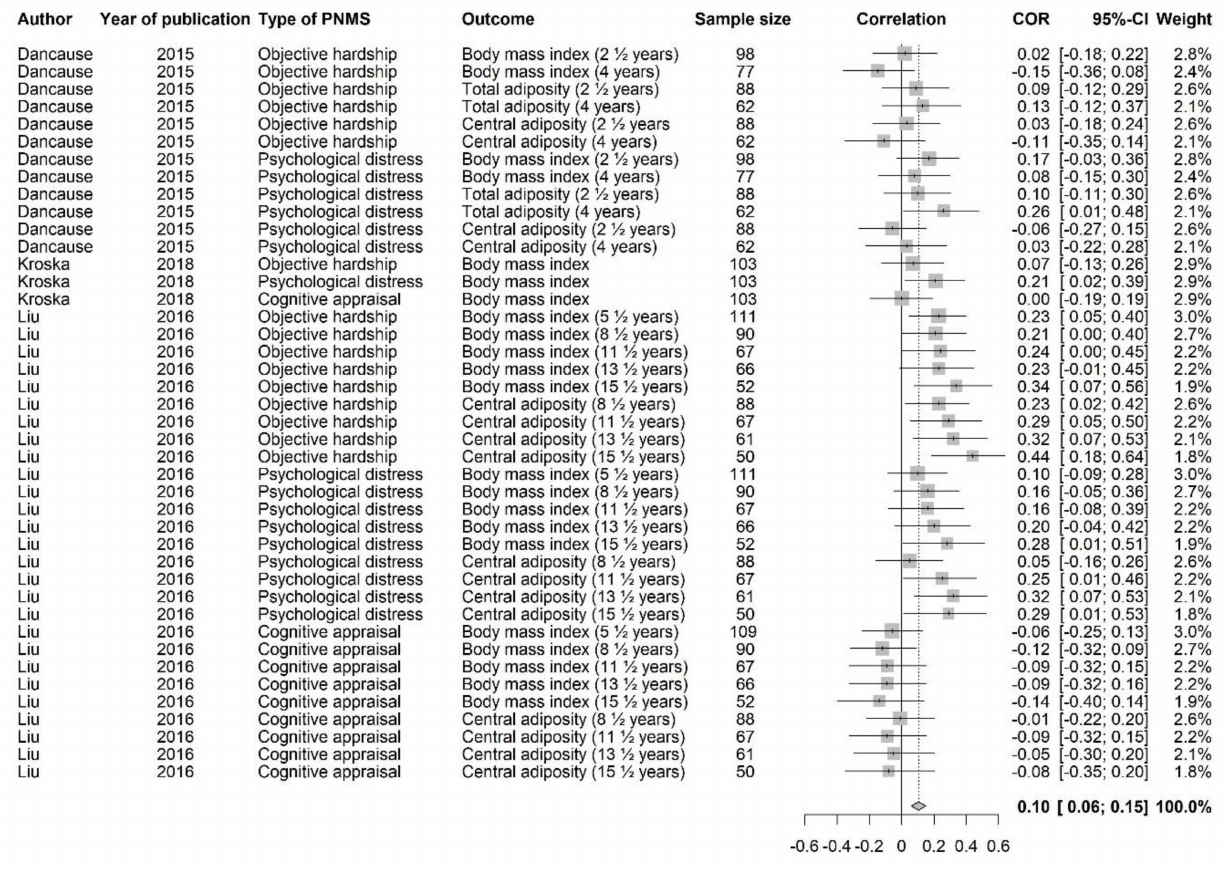
Figure 11. Physical outcomes forest